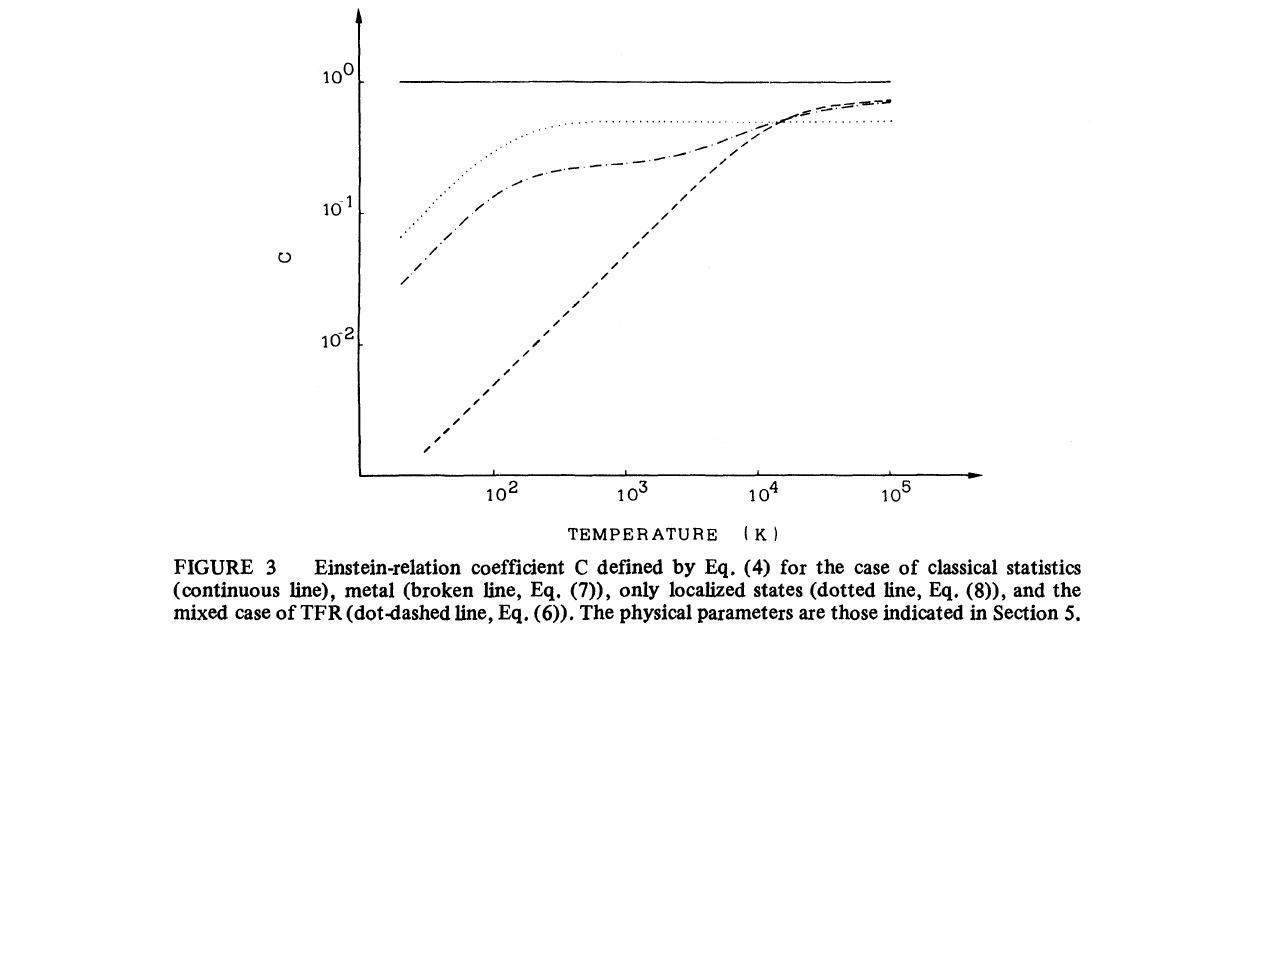
Einstein-relation coefficient C defined by Eq. (4) for the case of classical statistics (continuous line), metal (broken line, Eq. (7)), only localized states (dotted line, Eq. (8)), and the mixed case of TFR (dot-dashed line, Eq. (6)). The physical parameters are those indicated in Section